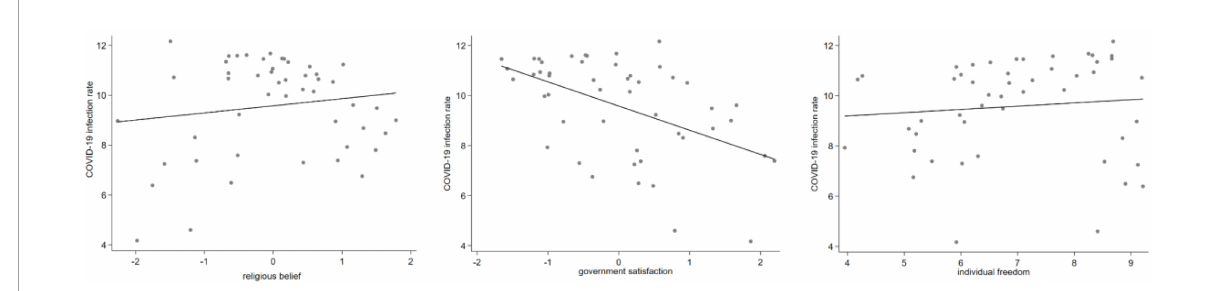
FIGURE2 Scatter plot of national values on the COVID-19 infection